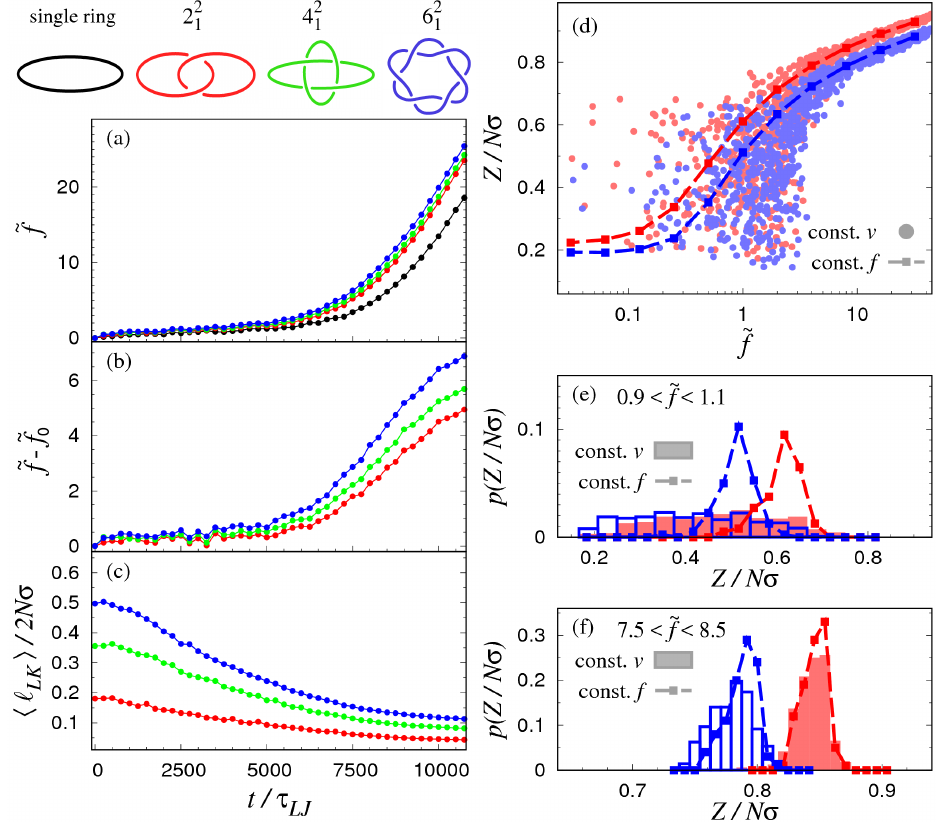
Figure 6. ( a ) Time dependence of the reduced force ˜ f measured at the termini of various link types (see color-coded legend) pulled at constant velocity. The black curve is the time-dependent reduced force, ˜ f 0 , for a single ring of equivalent length, 2 N σ , pulled with the same protocol. All curves are averages taken over 100 realizations. Panel ( b ) shows the difference of the time-dependent forces of the links and the equivalent ring; ( c ) Time dependence of the average contour length of the linked portion normalised to the total contour length of the link, 2 N σ ; ( d ) Scatter plot of the extension, Z , and reduced force ˜ f measured at equal times for the Hopf (red circles) and Star of David (blue circles) links. For comparison, the equilibrium force–extension curves (constant-force pulling protocols) are also provided. Normalised probability distributions of the normalised extension of Hopf and Star of David links for ( e ) large and ( f ) intermediate forces. The histograms pertain to the constant-velocity simulations, while the square datapoints and dashed lines outlines are for the constant-force